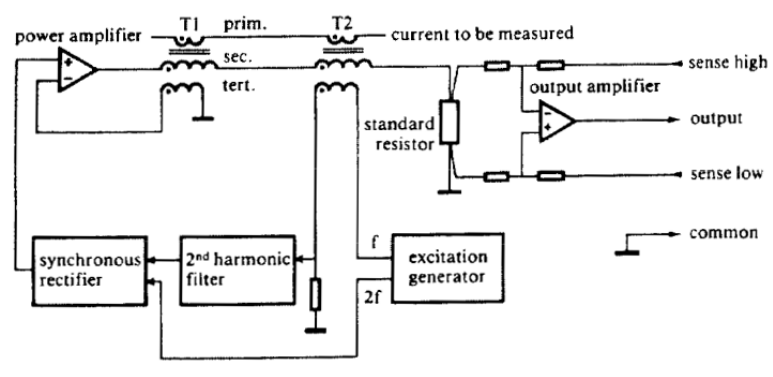
Figure 1. CERN: block diagram of zero-flux DCCT. c (cid:13) 1977 IEEE. Reprinted with permission from [13]. T1 as AC transformer, T2 as zero-flux sensor, prim. as primary current to be measured, and voltage